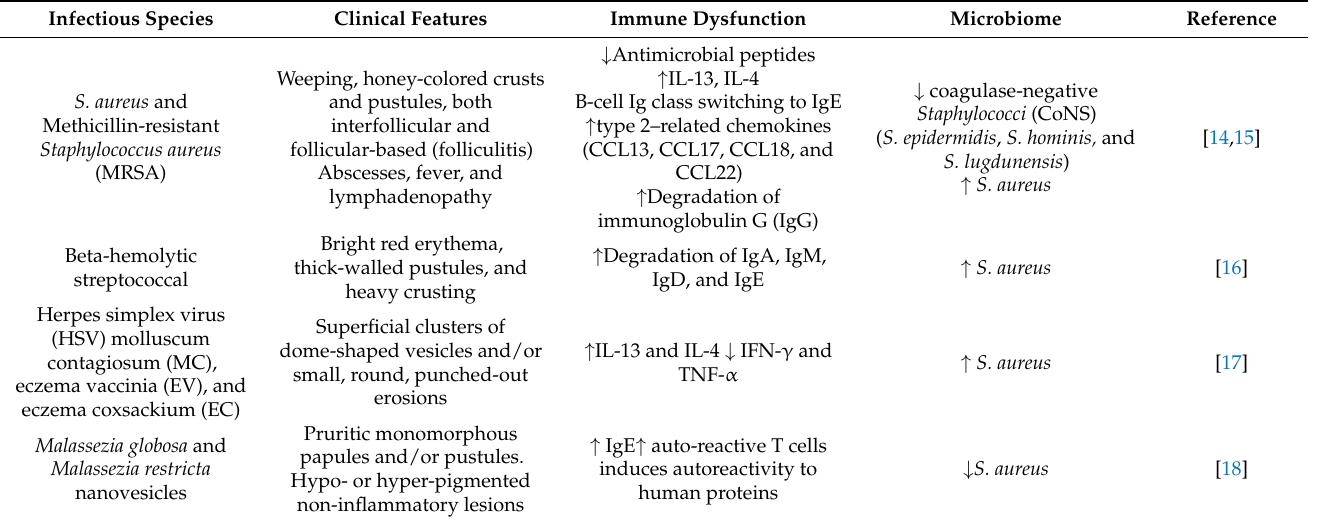
Table 1. Microbial skin infections and resultant changes in immune function and microbial composi- tion associated with